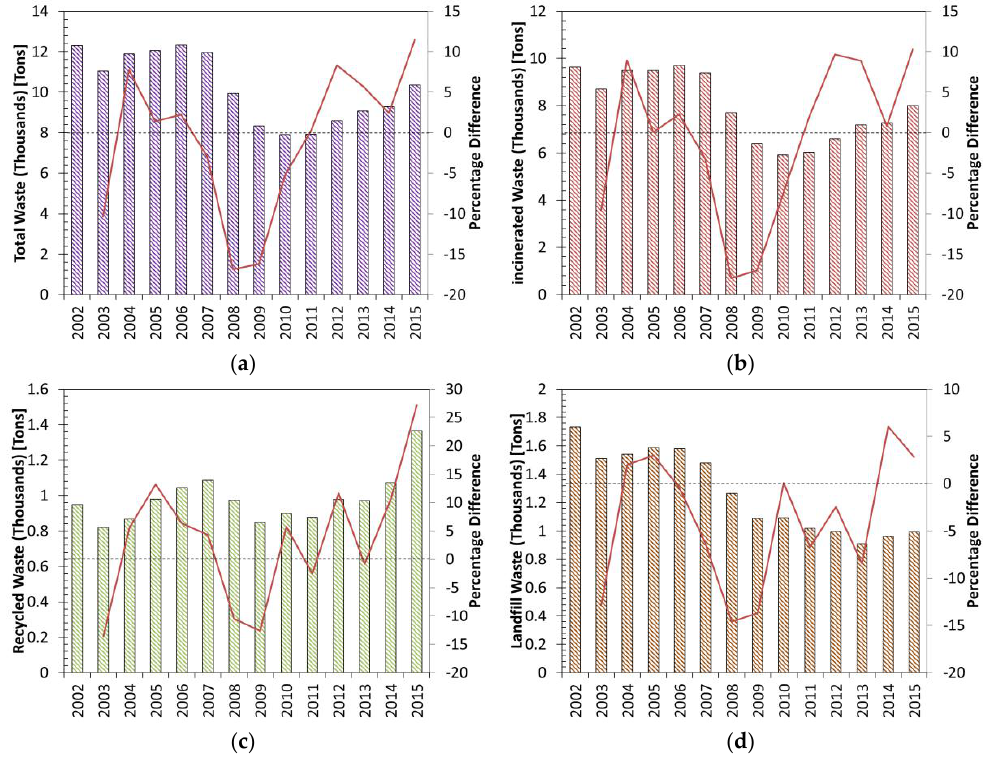
Figure 3. Annual waste quantities at Kansai International Airport during 2002–2015: ( a ) total; ( b ) incinerated; (c ) recycled; and ( d ) landfill. The solid line shows the year-on-year percentage change relative to the dashed line (0%). Data derived from [60,66].